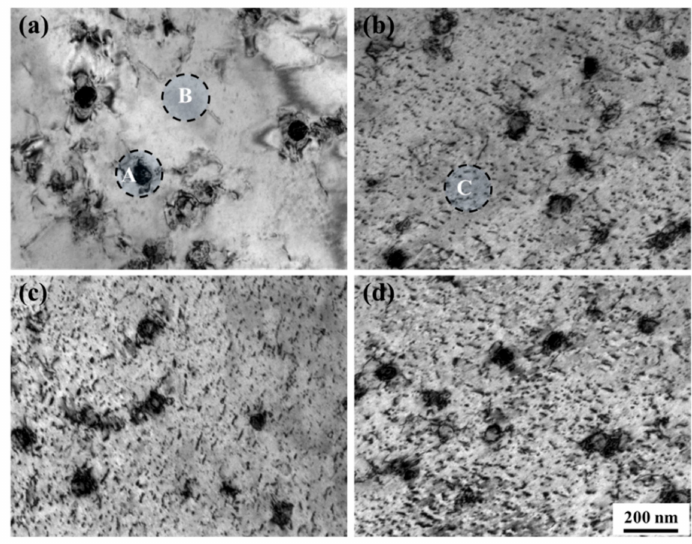
Figure 6. Bright-field TEM images of ( a ) C00, ( b ) C01, ( c ) C05 and ( d ) C10 specimens,